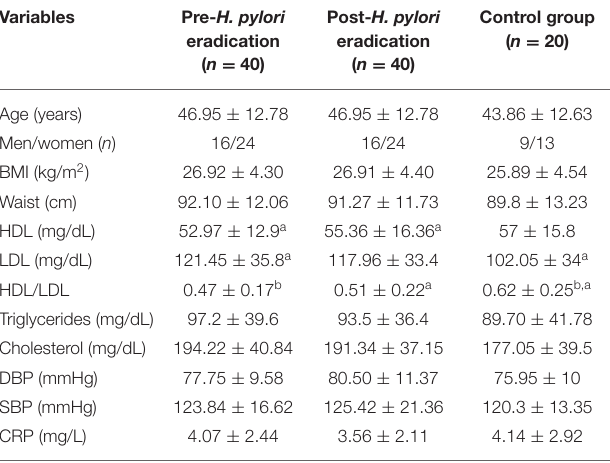
TABLE 1 | Characteristics of the study groups.